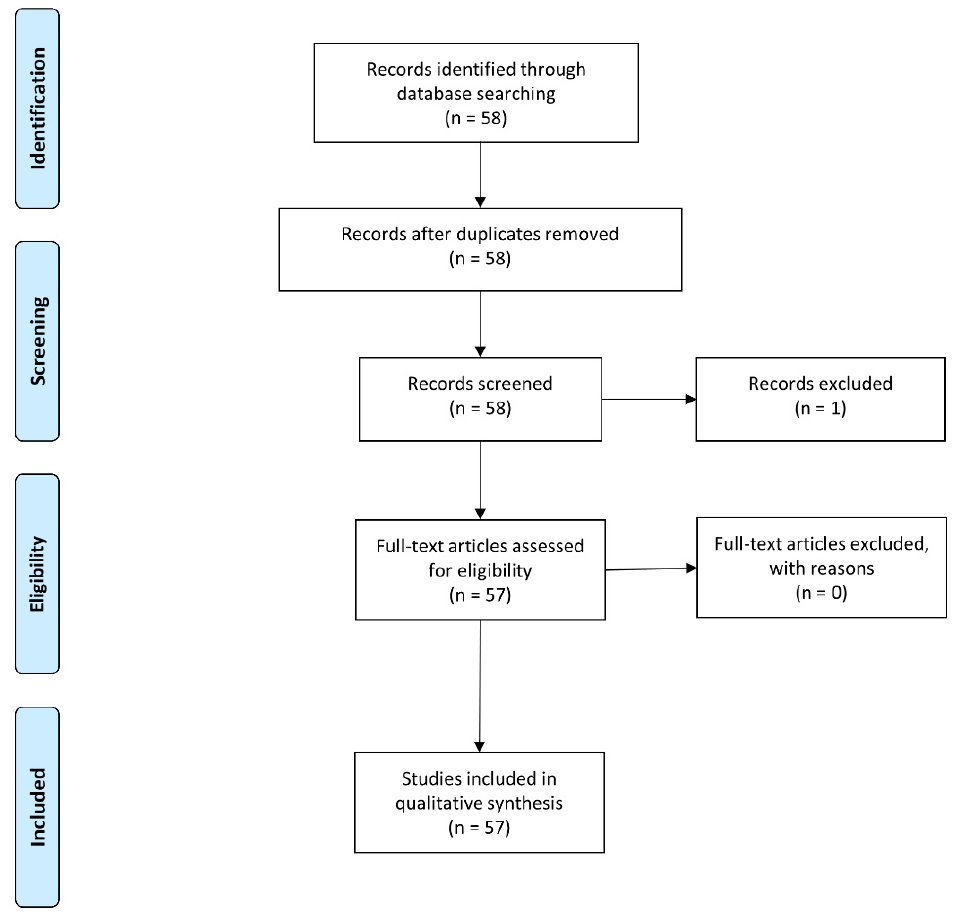
Figure 1. Literature selection process according to the Preferred Reporting Items for Systematic Reviews and Meta-Analyses guidelines.